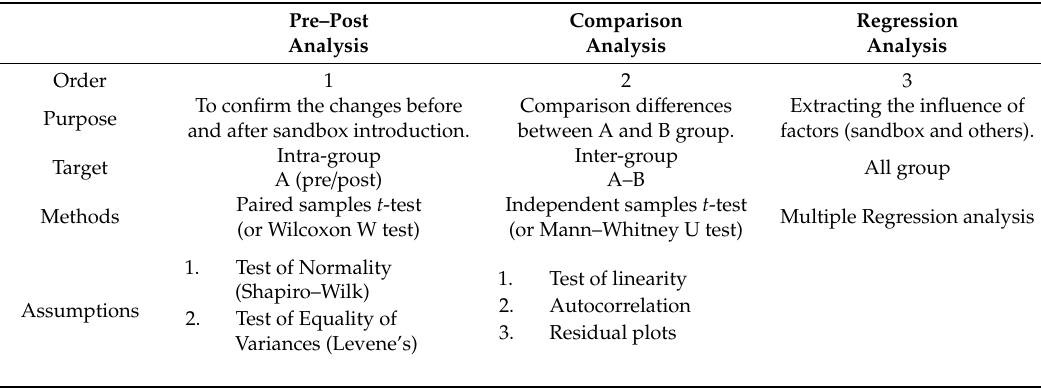
Table 3. The process of the